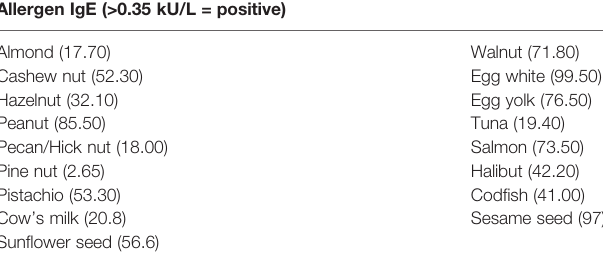
TABLE 1 | Allergen-speci fi c IgE. Allergen IgE (>0.35 kU/L = positive)